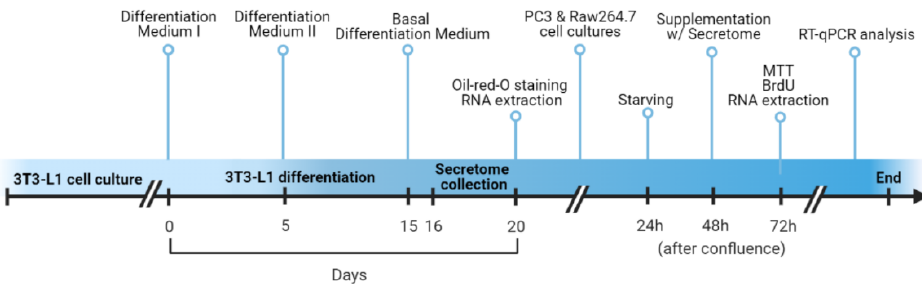
Figure 2. Schematic timeline of the experiment. We started with 3T3-L1 pre-adipocyte differentiation and at the end of the process (between 16 and 20 days), we collected the cell culture medium (secretome) and then we performed Oil-Red-O staining and RNA extraction. At 24 h after confluence, PC3, and Raw264.7 cell lines were submitted to starvation, and 24 h later, they were supplemented with the secretome previously produced by differentiated adipocytes. After that, the viability (MTT), proliferation (BrdU), and RNA extraction and analysis were assessed.